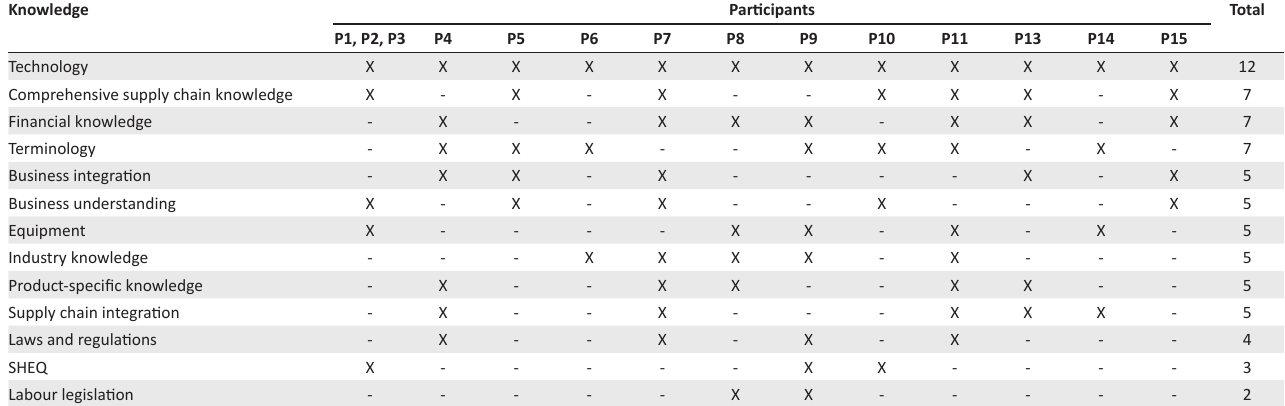
TABLE 9: The industry’s expectation concerning knowledge needed. Knowledge